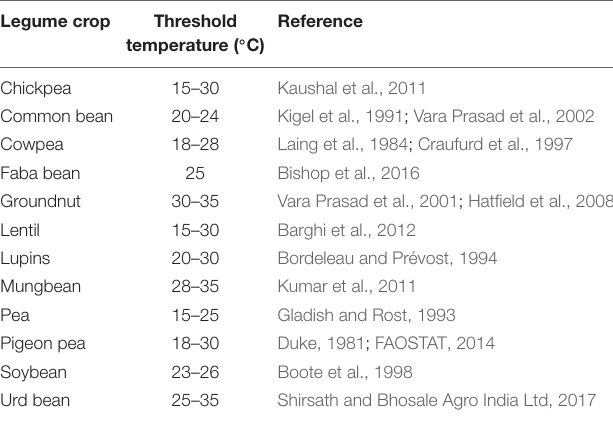
TABLE 1 | The heat stress threshold temperature range of some leguminous crops. Legume